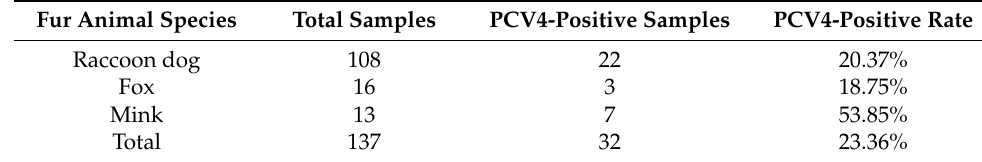
Table 2. PCR identification of PCV4 infection in diseased fur animals in Hebei Province of China. Fur Animal Species Total Samples PCV4-Positive Samples PCV4-Positive Rate Raccoon dog 108